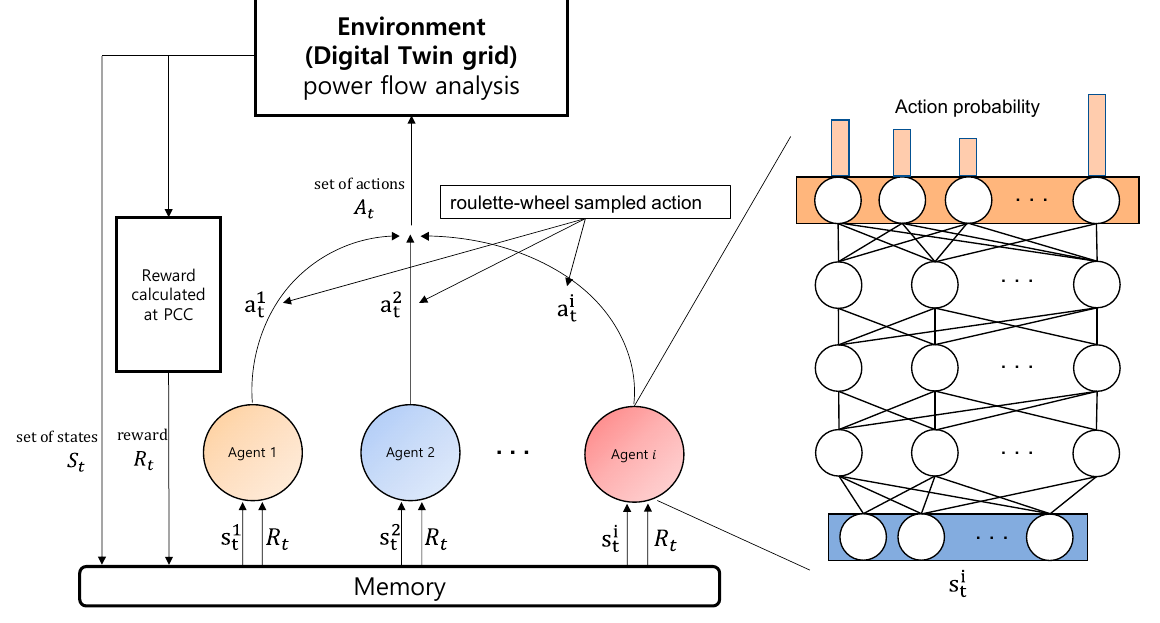
Figure 5. Training architecture for the proposed learning platform.